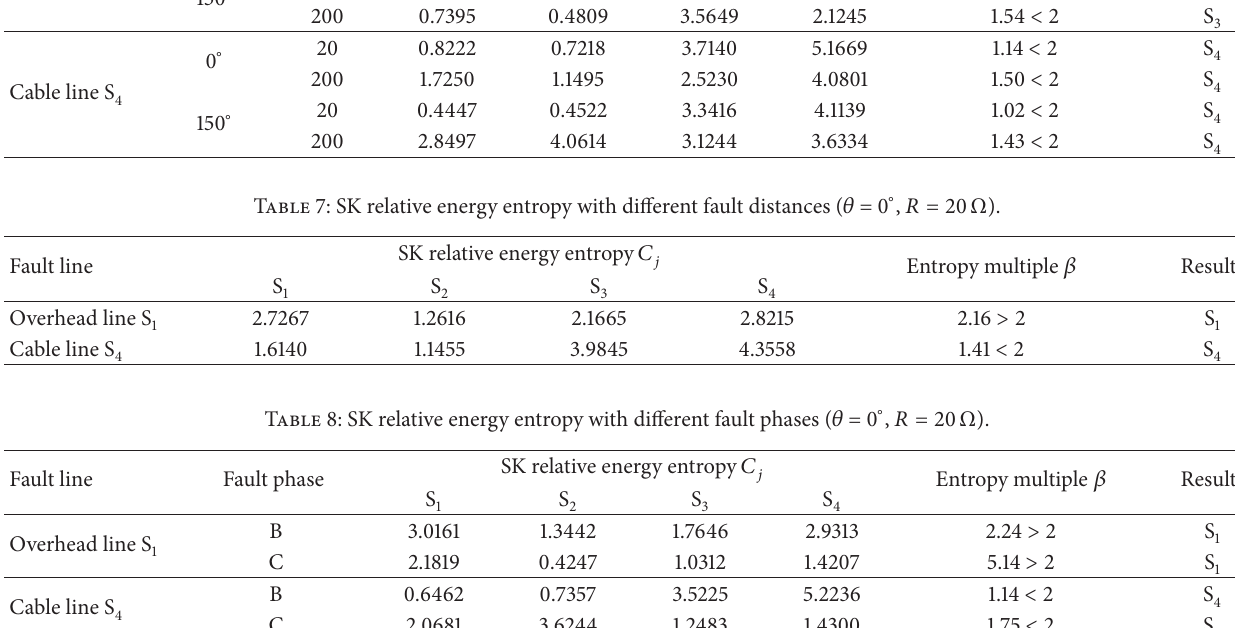
Table 6: SK relative energy entropy with S